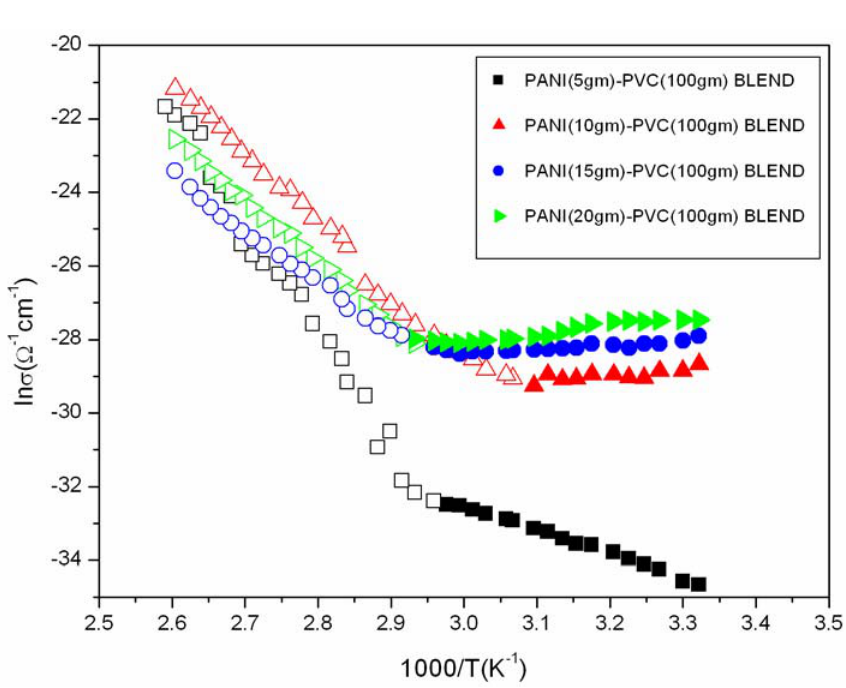
Fig. 4 Variation of dc conductivity with 1000/T for PANI doped with 10 % sulfamic acid in PANI-PVC blends.